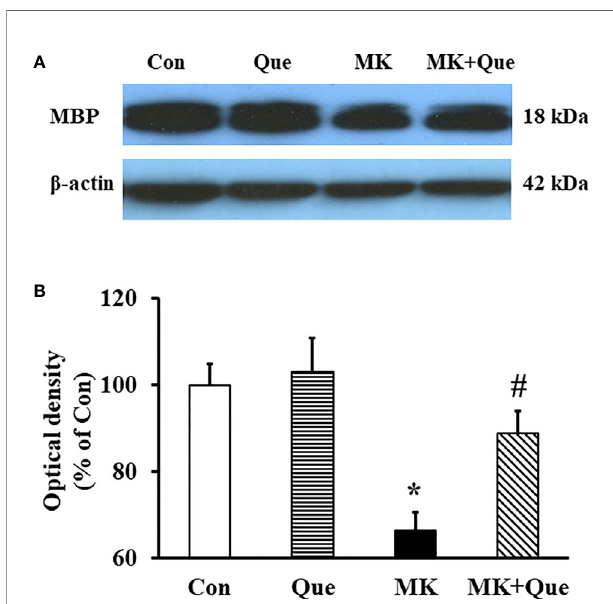
FIGURE 4 | (A) Representative western blot bands of myelin basic protein (MBP) protein expression in the frontal cortex of mice in control (Con), quetiapine (Que), MK-801 (MK), and MK-801+quetiapine (MK+Que) groups. (B) Histogram showing the quanti fi cation of the immmunochemically reactive bands in the Western blot of MBP in the frontal cortex of mice in the Con, Que, MK and MK+Que groups. Quetiapine attenuated the decrease of MBP level in the frontal cortex of MK-801 mice. n=5 in each group. Mice were treated with chronic quetiapine (10 mg/kg/day, intraperitoneally) for 28 days. From day 22 to 28, 1 h after the administration of quetiapine, the mice were administered MK-801 (2 mg/kg/day, subcutaneously). One day after behavioral testing, the mice were sacri fi ced for MBP protein analysis by western blot. Results are expressed as means ± S.E.M. * P < 0.05 vs. Con, # P < 0.05 vs. MK.